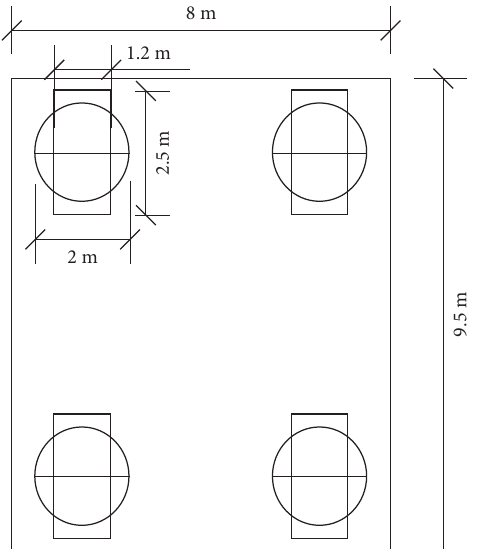
Figure 6: Pile foundation arrangement form of main bridge pier column.